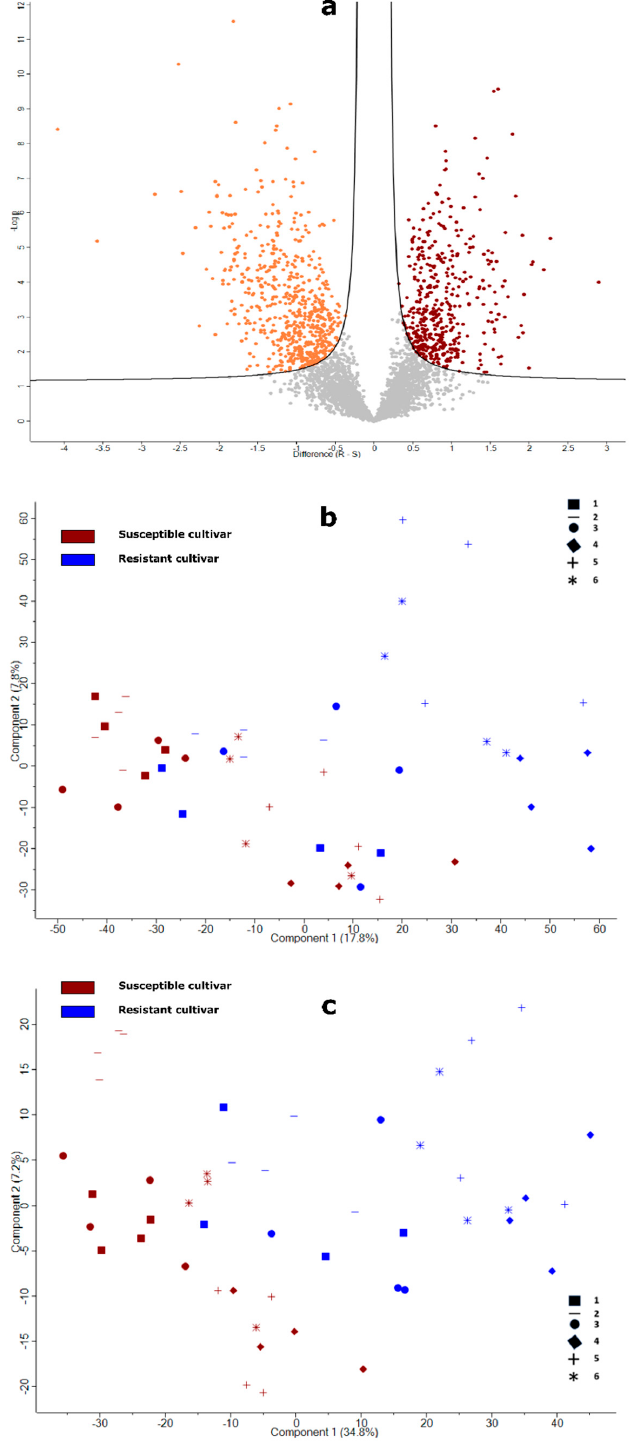
Figure 2. ( a ) Volcano plot displaying the results of t -test comparisons of susceptible and resistant potato cultivars. The two lines show the threshold (FDR < 0.05; s0 = 0.1) separating the proteins increased (dark red data points) and decreased in resistant cultivars (orange data points); ( b ) principal component analysis (PCA) of the dataset comprising all proteins quantified across the 12 potato cultivars; ( c ) PCA of the dataset restricted to the 1080 significant proteins between resistant and susceptible potato